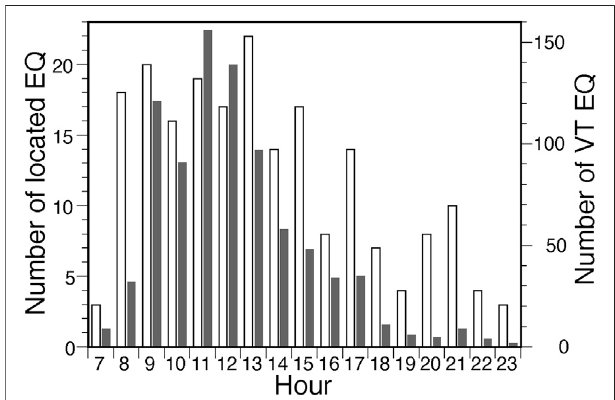
FIGURE5| HistogramofthenumberofVTearthquakes(graybars,right axis;Hottaetal.,2016a)andnumberoftherelocatedearthquakes(openbars, left